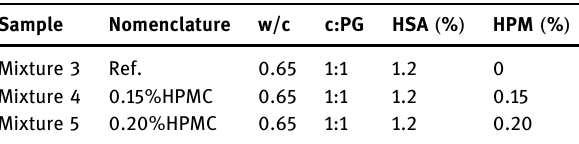
Table 3: Mixture proportions for start and end of setting time analysis